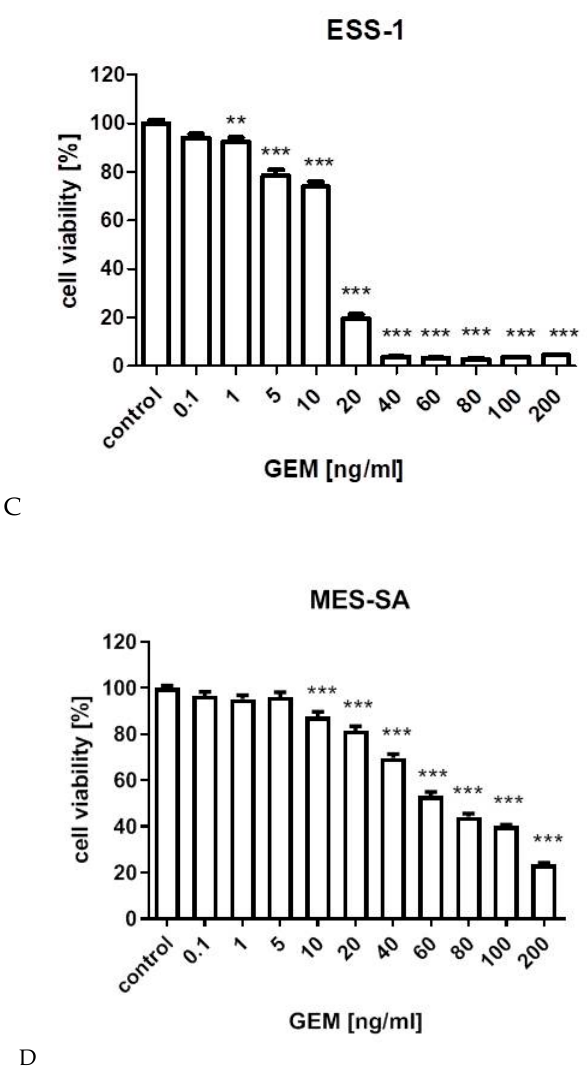
Figure 1. The influence of gemcitabine on the proliferation of carcinosarcoma cell lines (SK-UT-1 ( A ), SK-UT1-B ( B )), endometrial stromal sarcoma cell line (ESS-1 ( C )) and uterine leiomyosarcoma cell line (MES-SA ( D )). The cells were treated with the gemcitabine at various concentrations for 96 h. (** p < 0.01, *** p < 0.001 were considered as statistically significant).